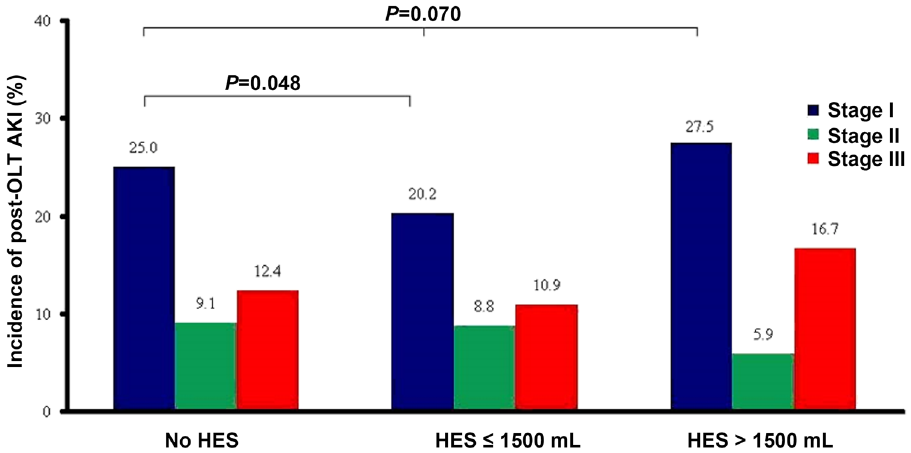
Figure 4: Incidence and stages of post - OLT AKI in patients with di ff erent HES exposures.